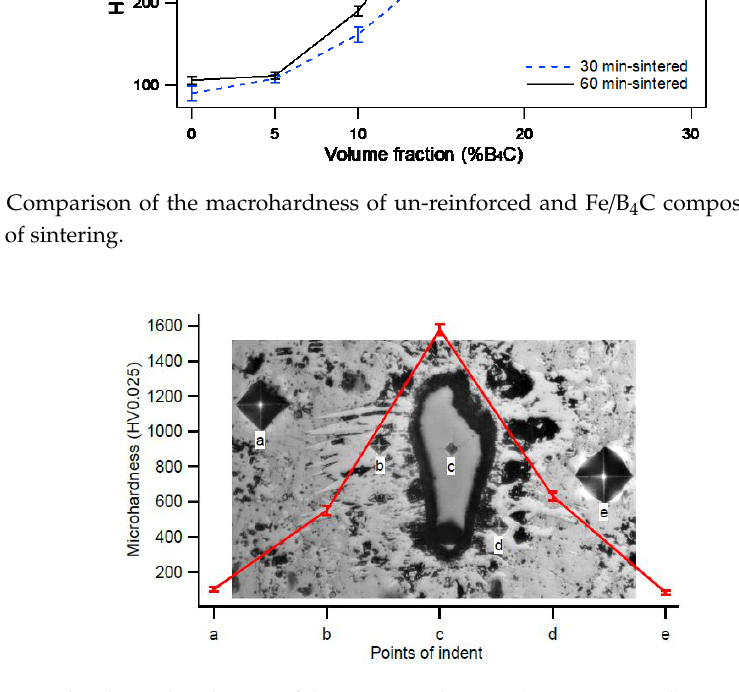
Figure 10. Microhardness distribution of the Fe + 10 vol.% B 4 C (30 min sintered) composite throughout the matrix and diffusion zone (HV 0.025